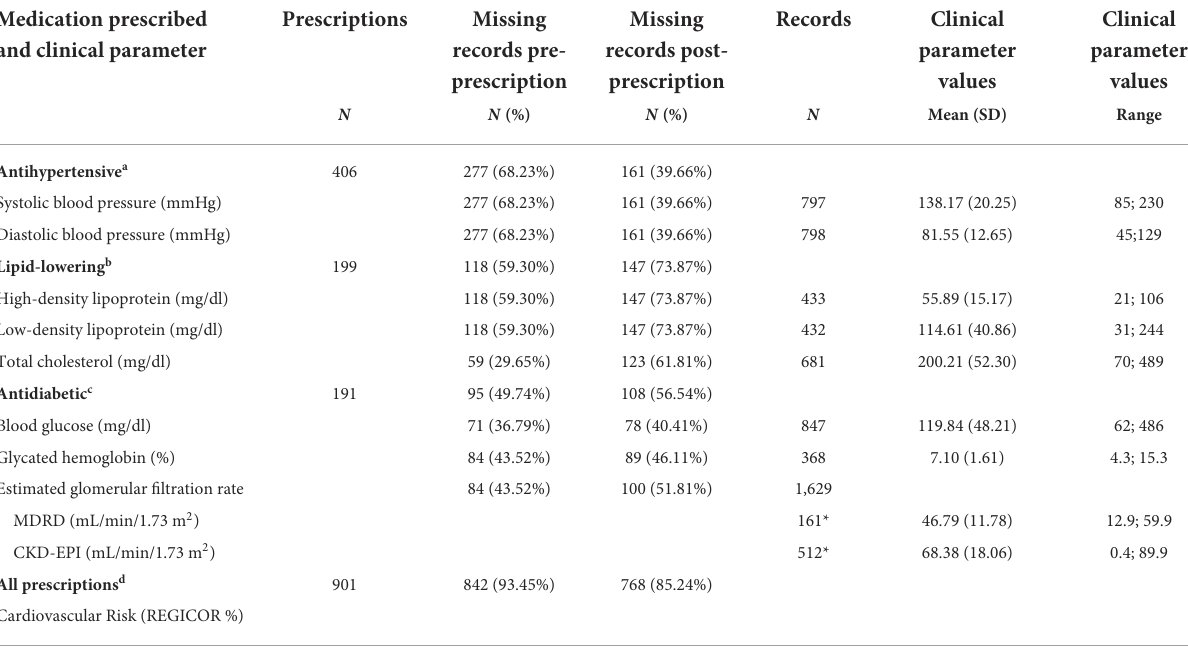
TABLE 3 Data availability and quality for clinical parameters for baseline (pre-prescription) and follow-up (post-prescription) assessment. Medication